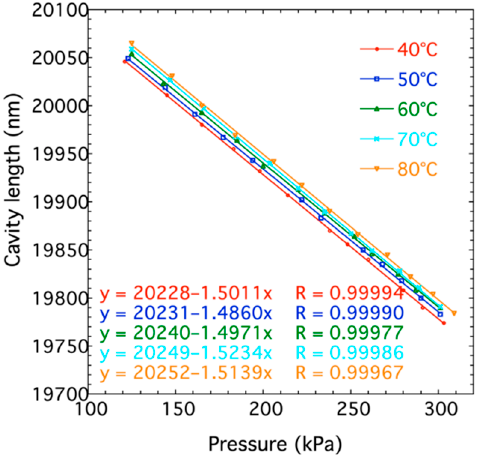
Figure 11. Relationship between cavity length and pressure at different temperatures.